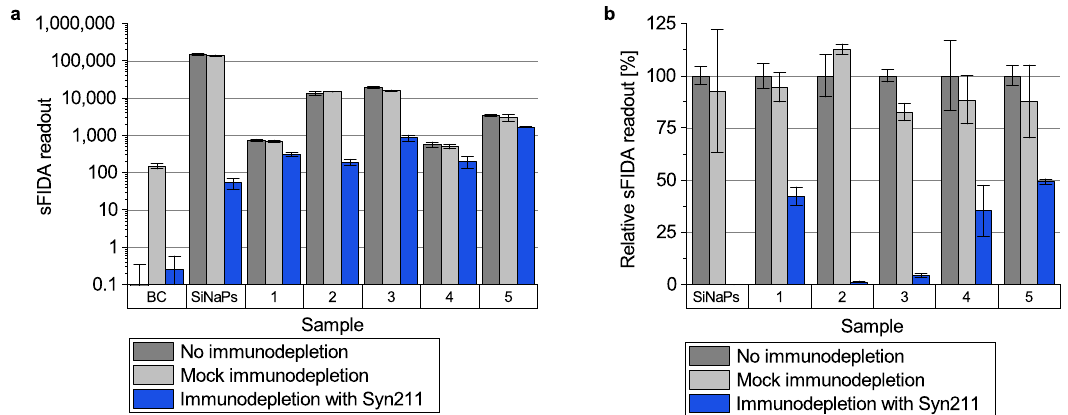
Fig. 5 Immunodepletion of α -synuclein SiNaPs and α -synuclein aggregates in stool samples. a The α -synuclein SiNaPs standard and fi ve stool samples were immunodepleted with magnetic beads coupled to Syn211 antibodies and, as a mock immunodepletion, without coupled antibodies. Immunodepletion entirely eliminated the sFIDA readout for α -synuclein SiNaPs (100%) and reduced that for α -synuclein aggregates in stool samples on average by 73%, ranging from 51% to 99% for different samples. Mock immunodepletion did not signi fi cantly affect the sFIDA readout with a reduction of about 7% for stool samples and α -synuclein SiNaPs. b The relative sFIDA readout [%] value represents the percent ratio of the sFIDA readouts of (mock) depleted to non-depleted